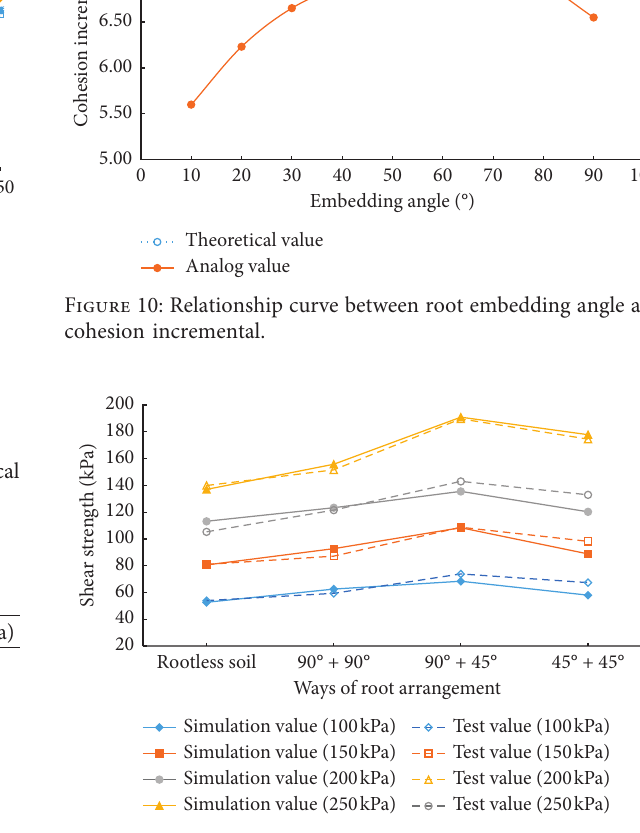
Figure 11: The relation curve between cloth root and shear